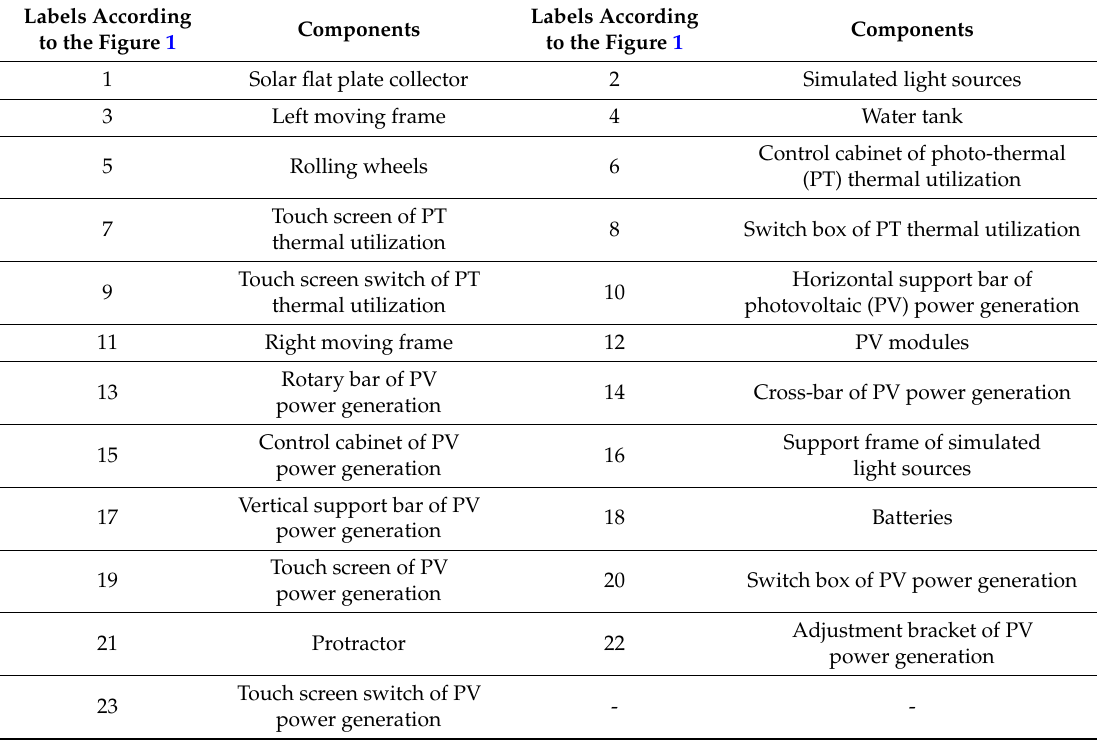
Table 1. The components according to the Figure